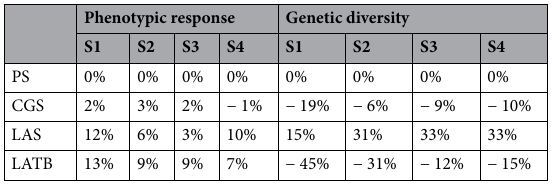
Table 2. Performance comparison against PS in the final